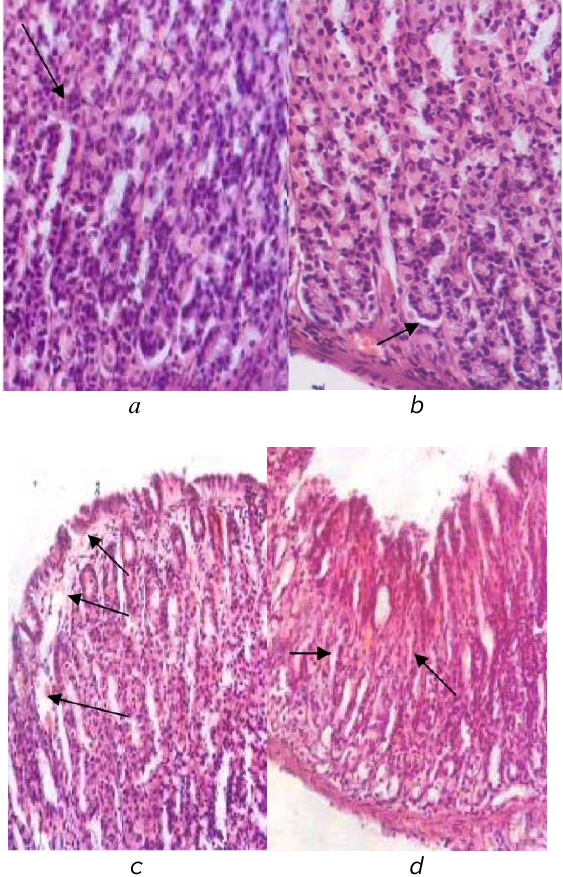
Fig. 10. The stomach of rats injected with dry extract of cabbage at a dose of: a – 40 mg/kg; b – 50 mg/kg; c, d – 30 mg/kg against the background of an alcohol- prednisolone mixture. The state of the main and parietal cells, the lumen of the glandular tubes corresponds to the normal; expansion of subepithelial capillaries without signs of expressive plethora in the prepyloric (c) and pyloric (d) parts. Haematoxylin-eosin. ×200 Power mucoid synthesis cells cover-pit epitheli- um, additional cells of their own and intermediary glands, cells of the pyloric glands are distinctly enlarged in comparison with the control conditions and did not differ significantly between the groups (Fig. 12).